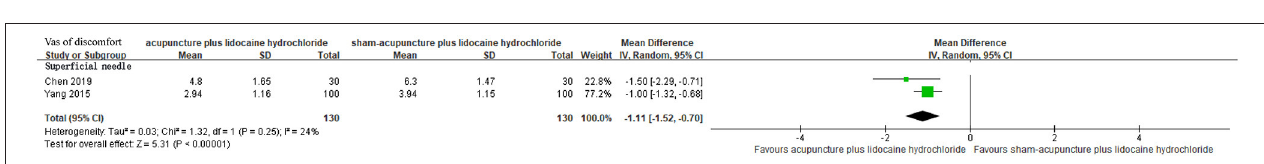
FIGURE 4 | Forest plots of comparison between acupuncture plus lidocaine hydrochloride and sham acupuncture plus lidocaine hydrochloride.